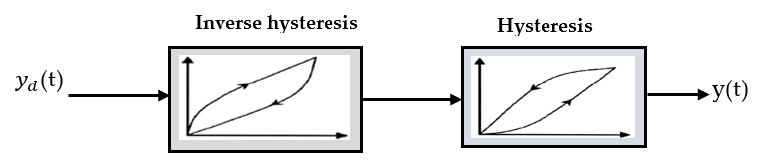
Figure 8. FF control compensation using the inverse model.